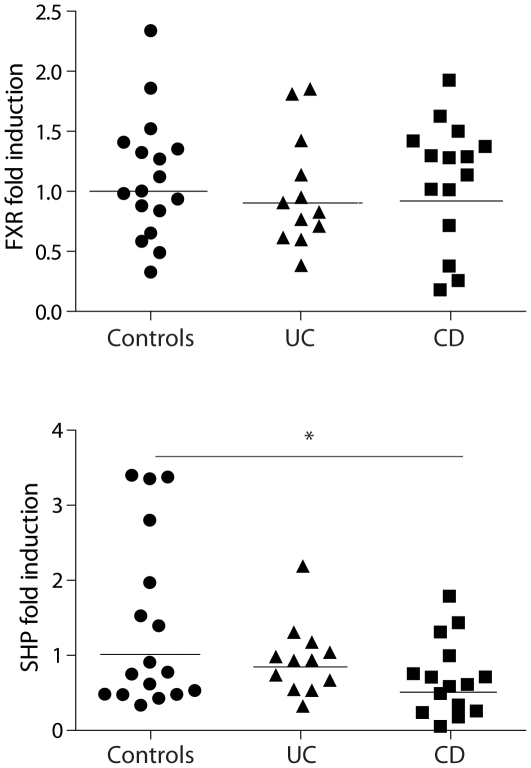
FXR target gene expression is decreased in patients with Crohn's disease.Scatter plot of mRNA expression of FXR and SHP in the ileal mucosa of healthy controls (circles), ulcerative colitis (triangles) and Crohn's disease patients (squares). Horizontal lines indicate mean values. *p<0.05 compared to healthy controls.